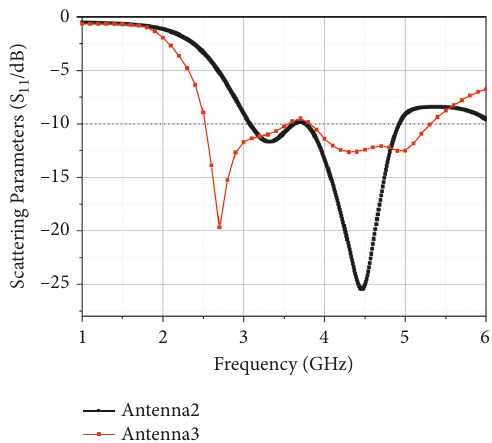
Figure 7: Reflection coefficients of antenna 2 and antenna 3.